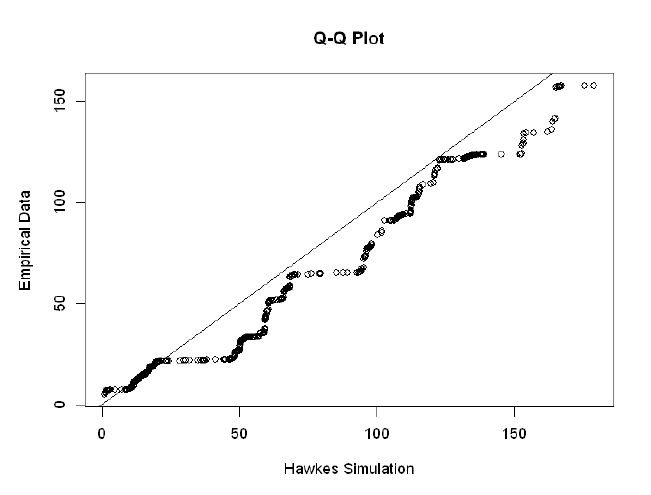
Figure 9. Q-Q plot of arrival time simulated by Hawkes process with parameters and empirical data of Group 1.